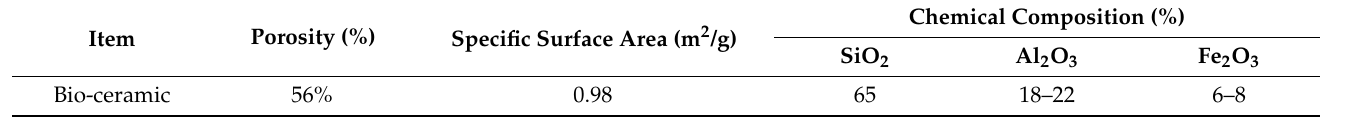
Table A3. Fundamental properties of